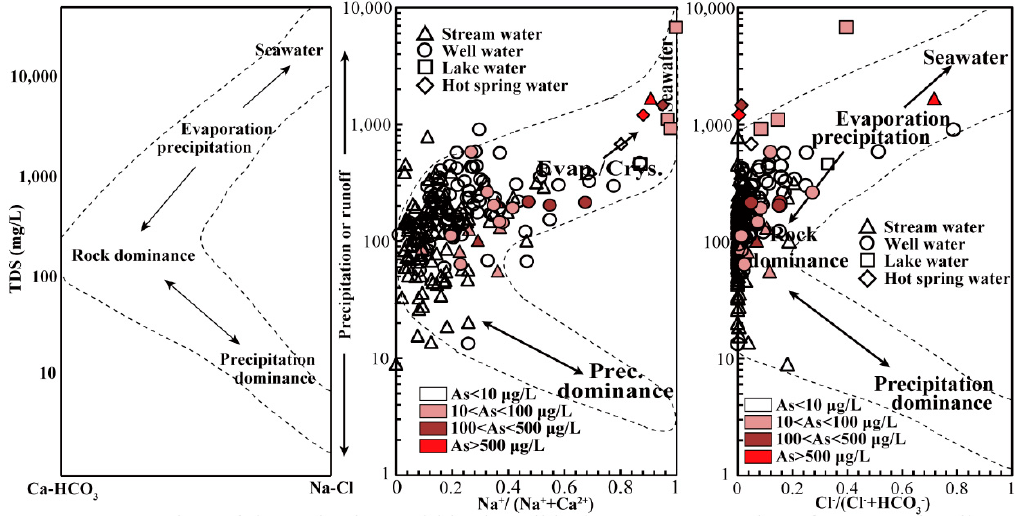
Figure 7. Plots of the major ions within the Gibbs boomerang envelope for waters in Tibet.